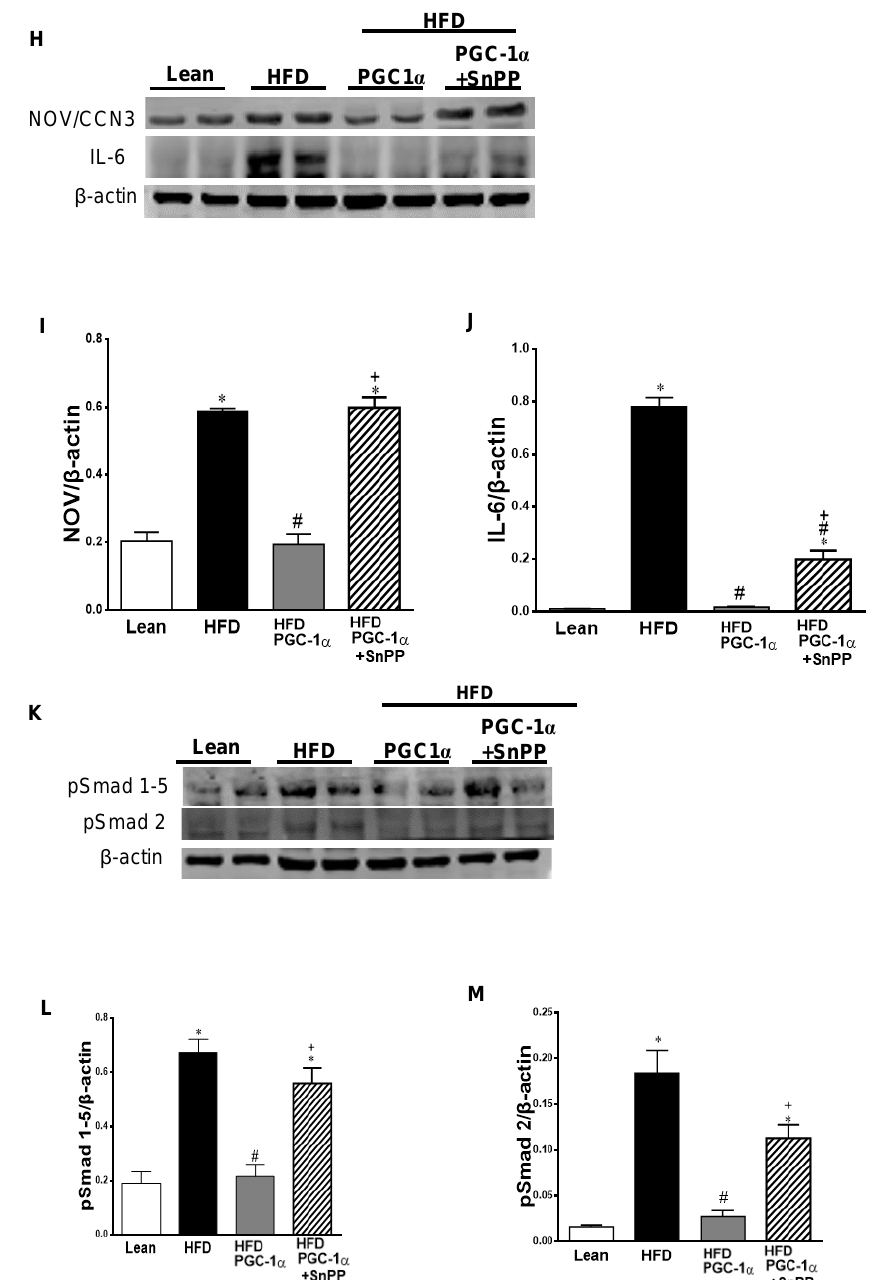
Figure 9. Effects of SnPP treatment on browning markers and AMPK phosphorylation in the adipose tissue of Transgenic-adipo-PGC-1 α mice fed with a high-fat diet. Representative Western blots of ( A ) PGC-1 α , HO-1, pAMPK, and AMPK with the corresponding quantitation to β -actin ( B – D ). ( E – G ) UCP1 and PRDM16. Data are expressed as mean ± S.E.M. ( n = 5); * p < 0.05 vs. lean; # p < 0.05 versus H.F.D.; + p < 0.05 vs. PGC-1 α . Effects of SnPP treatment on inflammatory mediators and transforming growth factor β (TGF- β ) signaling (pSmad 1–5 and pSmad 2) in the adipose tissue of Transgenic-adipo-PGC-1 α mice fed with a high-fat diet. Representative Western blots of ( H – J ) NOV/CCN3 ( H ) and IL-6 ( J ) with the corresponding quantitation to β -actin; Representative Western blots of pSmad 1–5 and pSmad2 with the corresponding quantitation to β -actin (9; K – M ); and phosphorylation of pP38 MAPK (9N) with the corresponding quantitation to pP38 MAPK. Data are expressed as mean ± S.E.M. ( n = 5); * p < 0.05 versus lean; # p < 0.05 versus H.F.D.; + p < 0.05 versus PGC-1 α